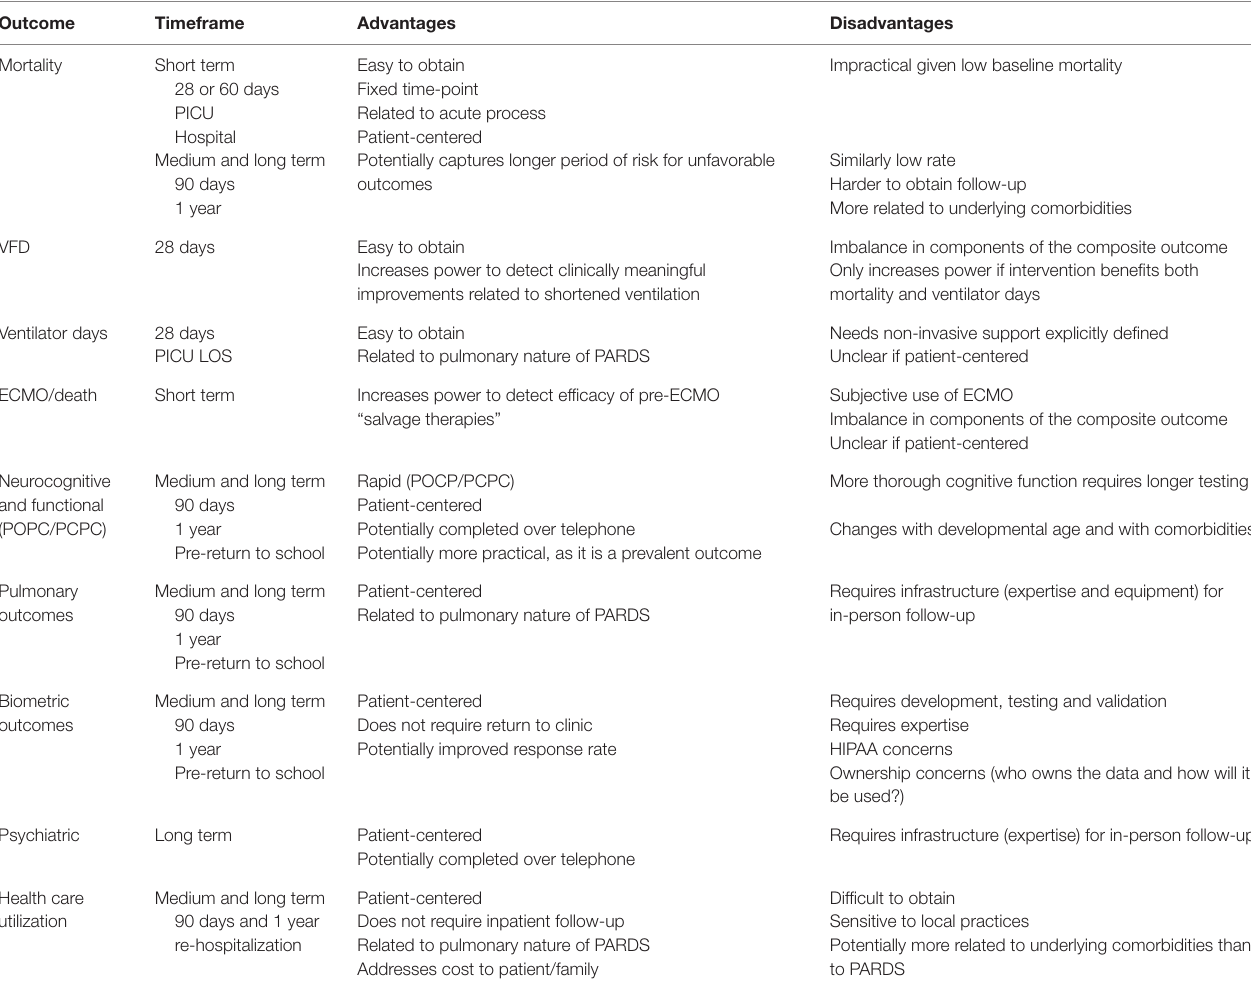
TABLe 3 | Potential outcomes for PARDS